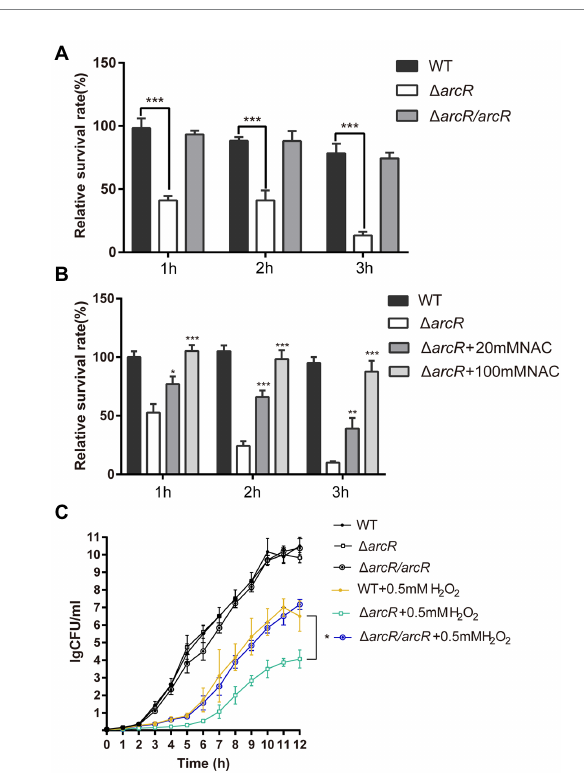
FIGURE 3 Roles of ArcR in bacterial tolerance to neutrophils and H 2 O 2 . (A) Bacteria were incubated with mouse neutrophils at an MOI of 5 in HBSS or (B) HBSS containing 80 mM NAC. Live bacterial counts were determined every hour for 3 h. (C) Bacteria were treated with 0.4 mM H 2 O 2 for 12 h in TSB at 37 ° C. Live bacterial counts were determined by serial dilution and plating. The survival rate was calculated as the number of CFUs of each strain after individual treatment divided by the number of CFUs in the corresponding sample before treatment. The data represent results from three independent experiments. * p < 0.05, ** p < 0.01, and *** p < 0.001, by Student’s t